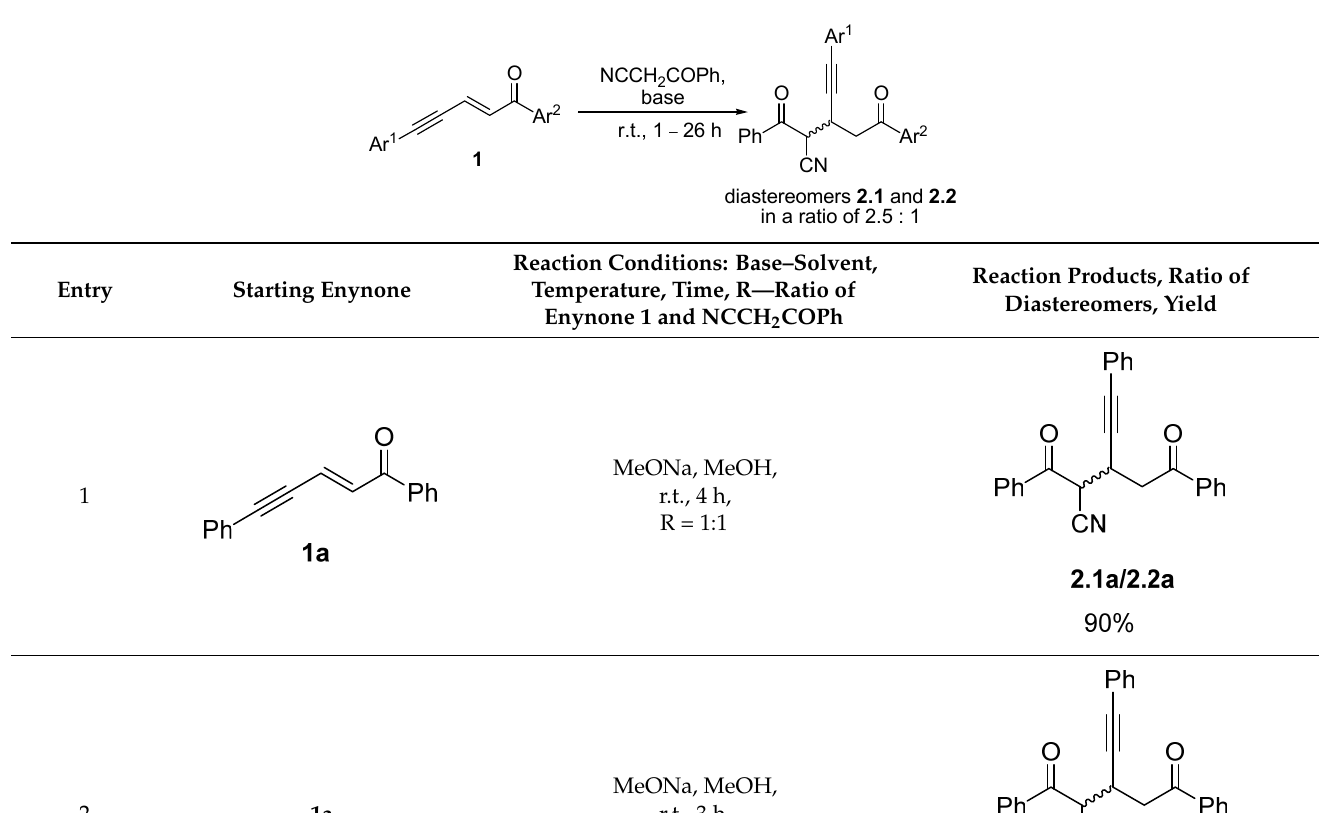
Table 1. Reactions of enynones 1 with 3-oxo-3-phenylpropanenitrile and sodium methoxide in methanol leading to δ -diketones 2.1 / 2.2 .